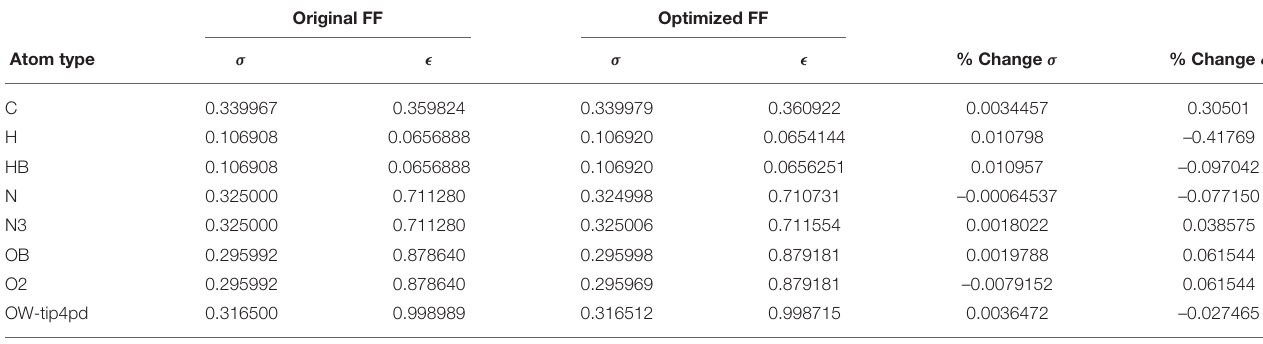
Refer to the Table 2 legend for an explanation of the atom types.